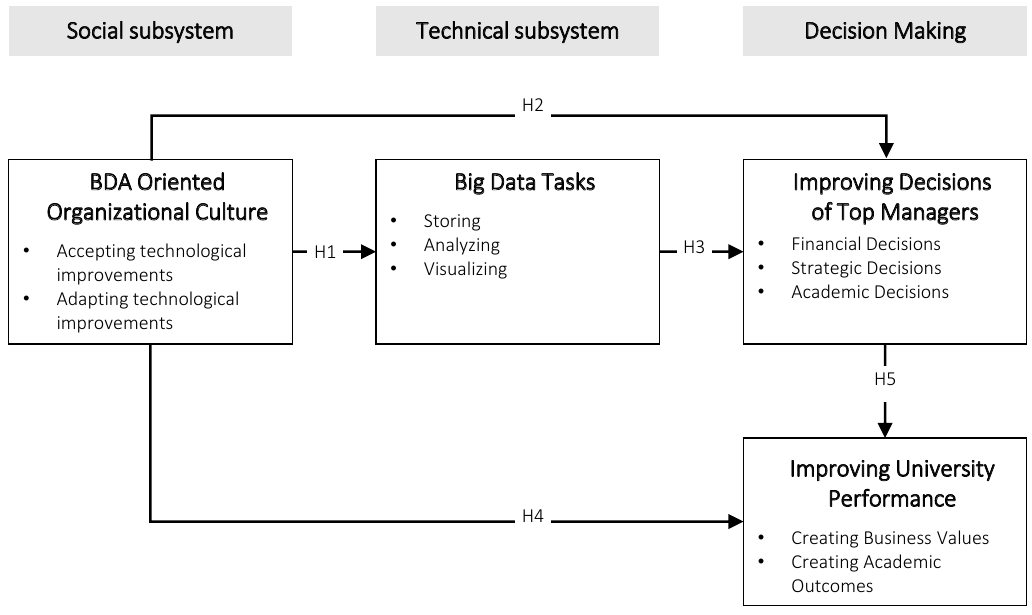
Figure 1. Research model showing the relationship between social subsytem, technical subsytem and improved decision